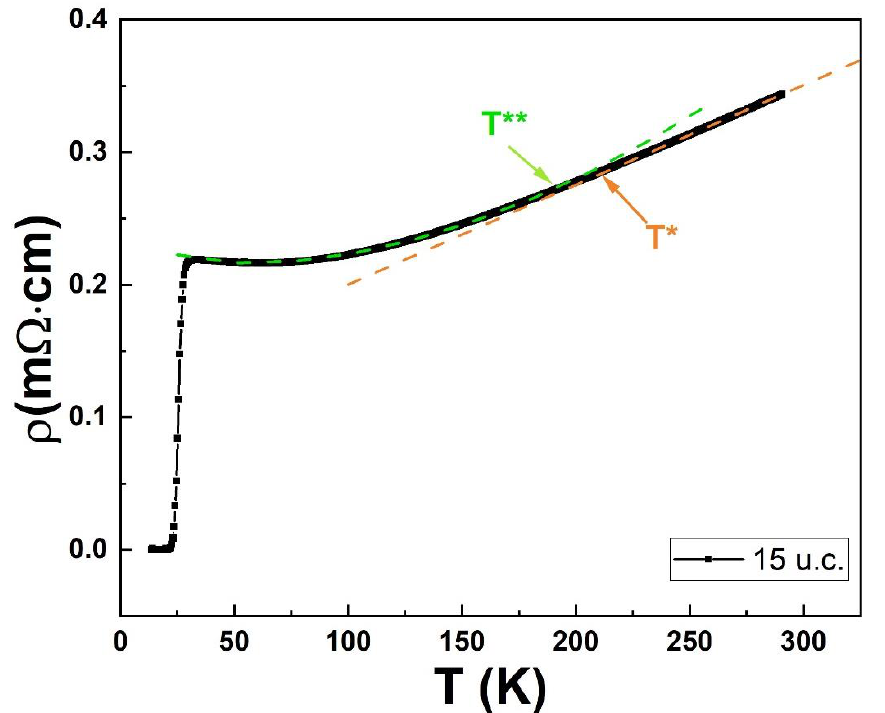
Figure 2. ρ (T) curve for the trilayer with the 15 u.c. thick central layer. The meaning of the T* and T** temperatures is discussed in the text .